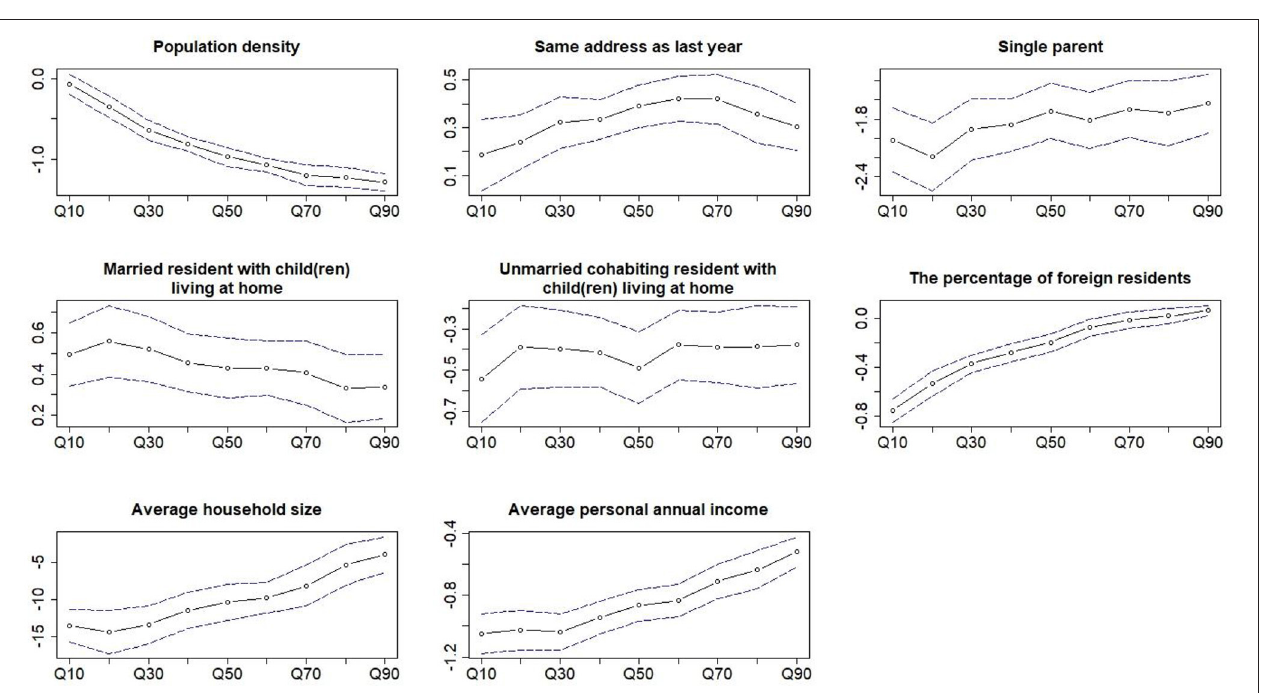
regression ( Figure 2 ) ( Supplementary Material Figure 3 ). The percentage of single parent, average household size, and